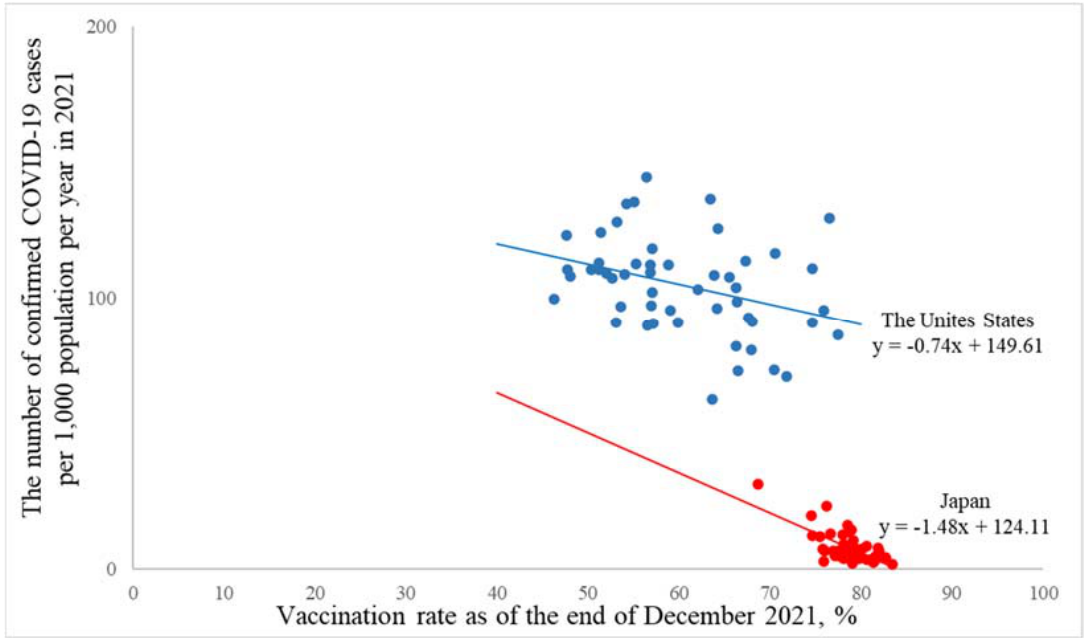
Figure 3. A macro-level association of the vaccination rate with the number of confirmed COVID-19 cases per year based on the jurisdictions in the United States and Japan. Blue dots are jurisdictions in the United States, and red dots are jurisdictions in Japan. The line shows the slope based on the generalized regression model as an approximated curve. The covariate was not included in this